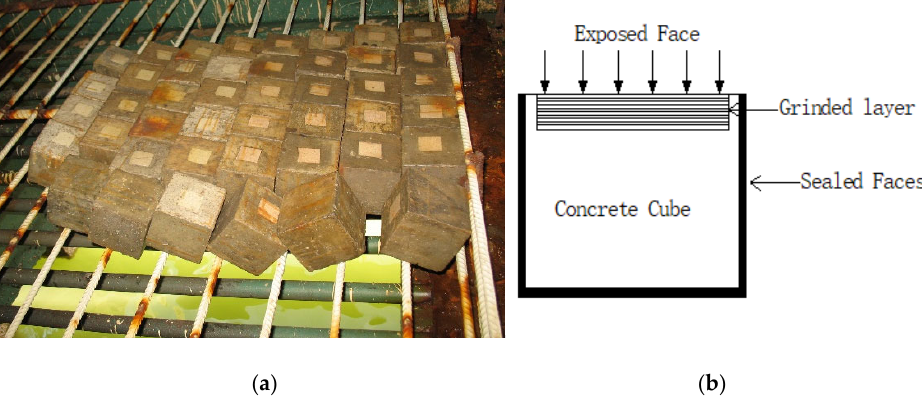
Figure 2. ( a ) Concrete specimens at the exposure test station and ( b ) Schematic diagram of concrete specimen testing.